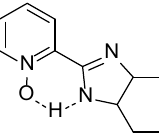
Figure 1. Representation of the possible hydrogen bond formation in 22 .